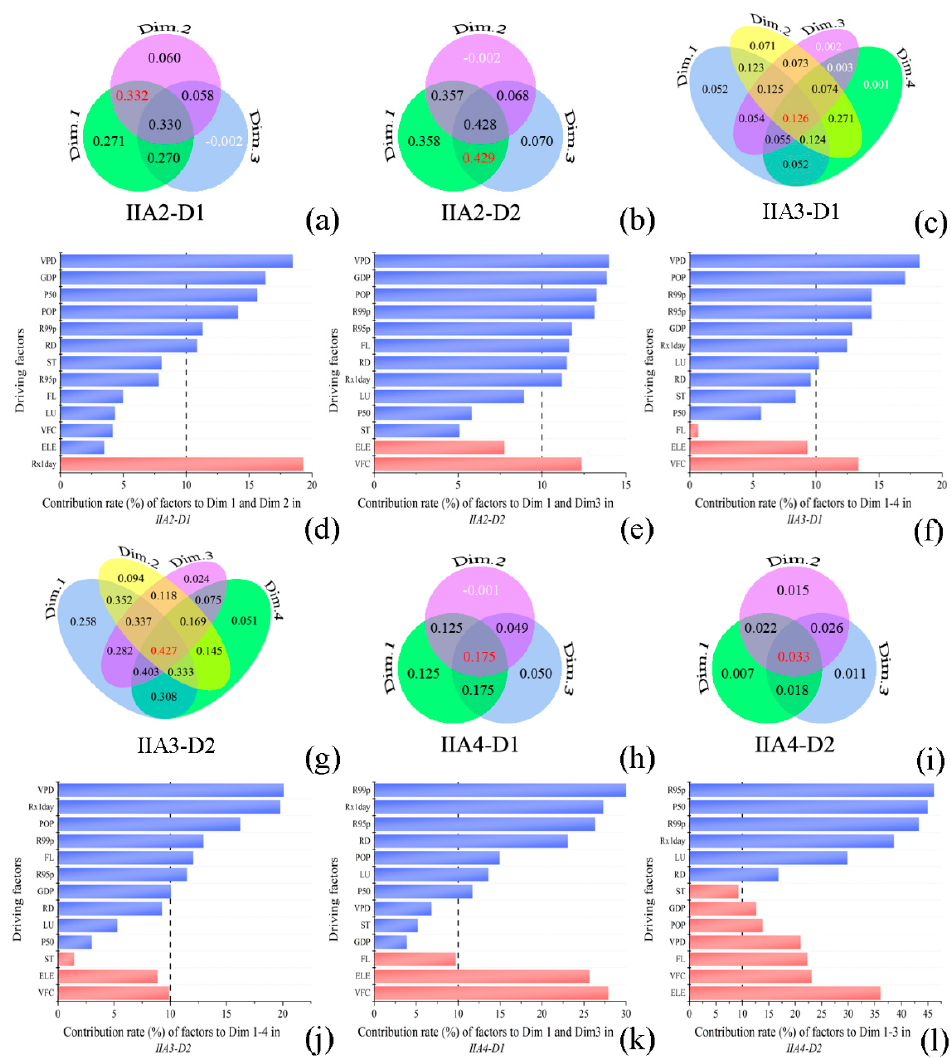
Figure 6. Interaction detection analysis based on principal component analysis and multiple linear regression in di ff erent geomorphological regions from D1 to D2. ( a , c , h ) are R 2 values of the multiple linear regression (MLR) of the principal components for flash floods in the IIA2, IIA3, and IIA4